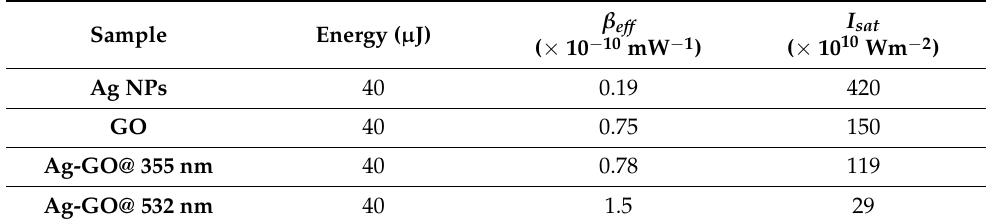
Table 3. Values of nonlinear absorption coefficient ( β eff ) and saturation intensity ( I Sat ) for excitations in the nanosecond